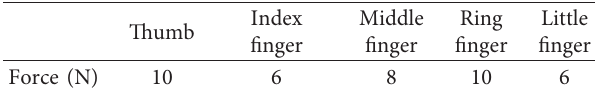
Table 8: Fingertip force for each finger actuated by SMA